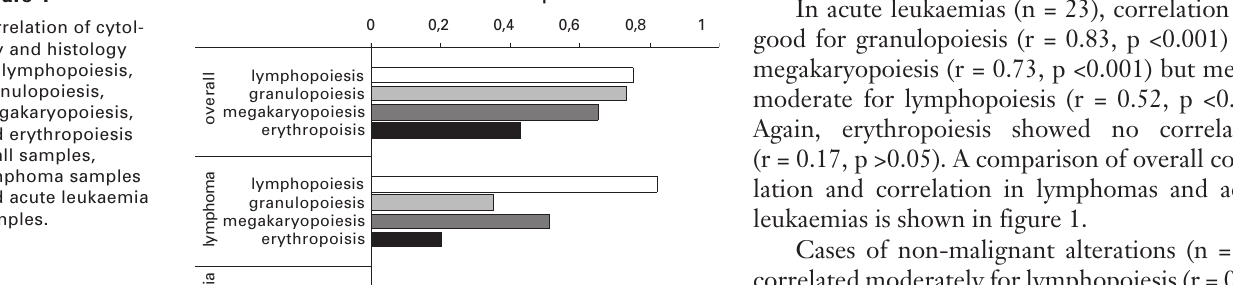
Correlation of cytol- ogy and histology for lymphopoiesis, granulopoiesis, megakaryopoiesis, and erythropoiesis in all samples, lymphoma samples and acute leukaemia